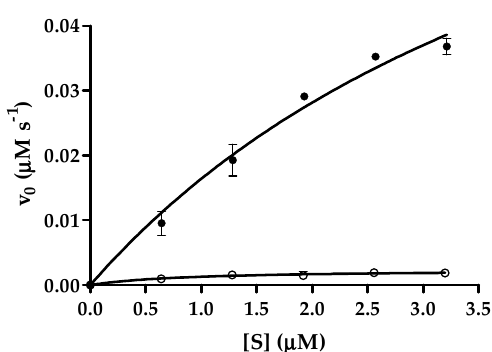
Figure 10. Kinetic analysis of SARS-CoV-2 3CLpro using recombinant fusion protein substrates. Data obtained for His 6 -MBP-TSAVLQ*SGFRKM-mEYFP and His 6 -MBP-REGTRVQ*SVEQIRE-mEYFP substrates are shown by full circles and squares, respectively. Averages of values obtained from two parallel experiments are plotted, error bars represent SD. Kinetic parameters are shown in Table 2. Table 2. Kinetic parameters determined for SARS-CoV-2 3CLpro using His 6 -MBP-TSAVLQ*SGFRKM-mEYFP and His 6 -MBP-REGTRVQ*SVEQIRE-mEYFP substrates. Data were calculated based on the results of two parallel experiments. Cleavage Site K M (µM) kcat (s -1 ) kcat/K M (µM -1 s -1 ) TSAVLQ*SGFRKM 5.086 ± 2.046 1.349 ± 0.370 0.2652 ± 0.1291 REGTRVQ*SVEQIRE 0.860 ± 0.303 0.0033 ± 0.0004 0.0038 ± 0.0014